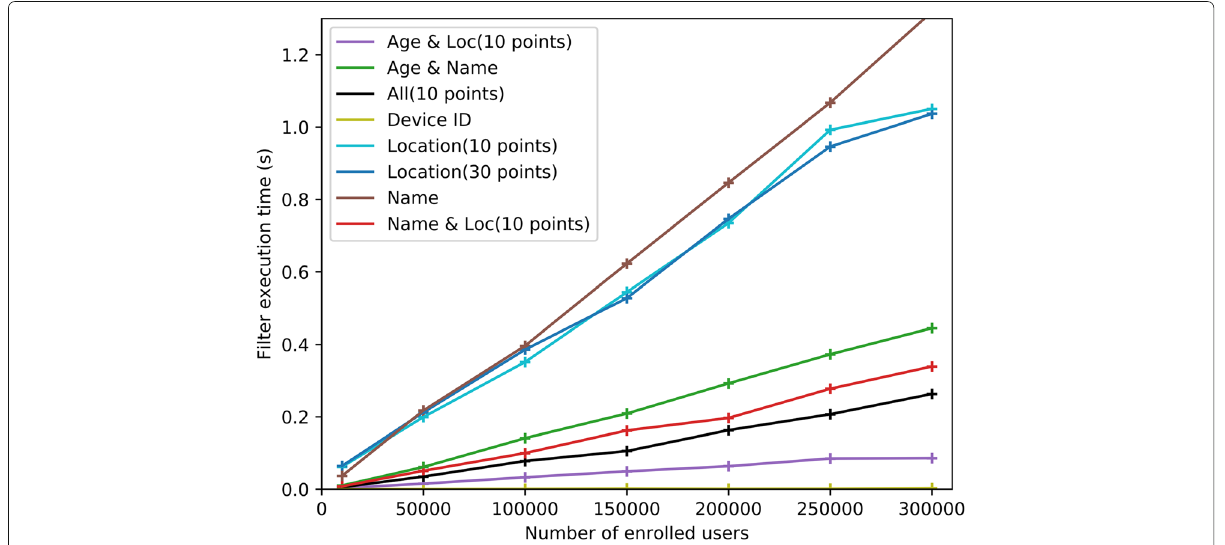
Fig. 9 Average computation times for the investigated